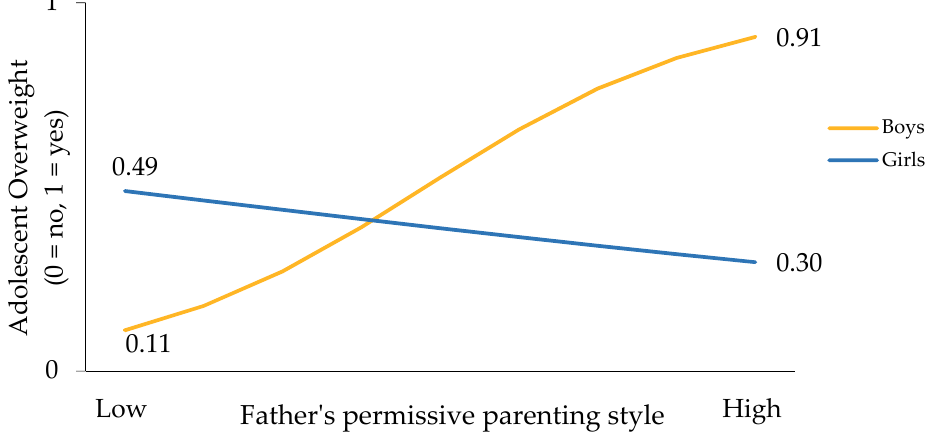
Figure 2. Moderating effect of sex on the relationship between permissive fathers and adolescent overweight in urban areas.